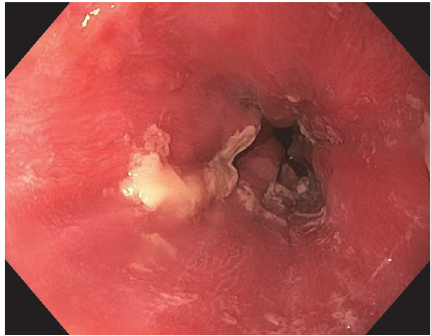
Figure 2: Endoscopic image of esophagitis extending to the gastroe- sophageal junction at 40 cm.